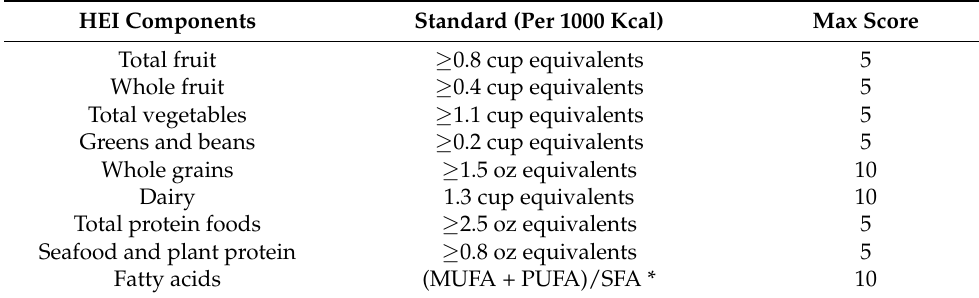
Table 1. Adequate intake HEI component scoring standards.